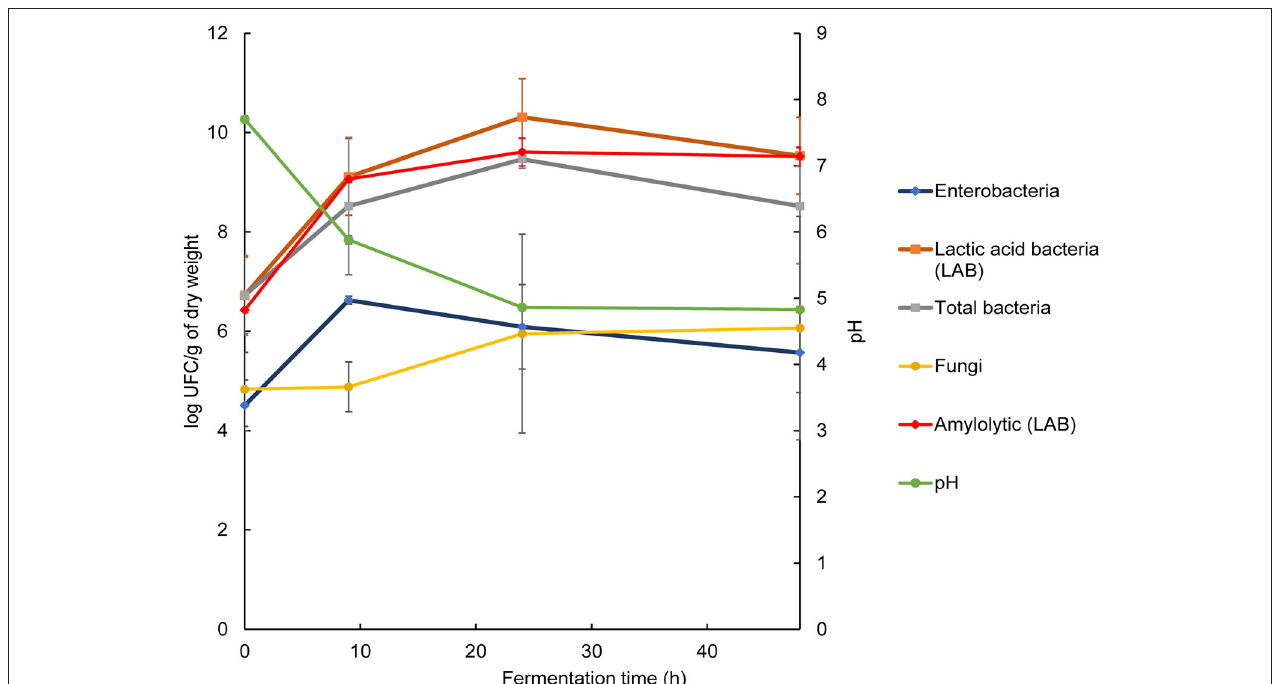
FIGURE 1 | Microbial and chemical changes during pozol fermentation. Concentration of microorganisms and pH values. The results are expressed as the mean of three replicates ± standard deviation.